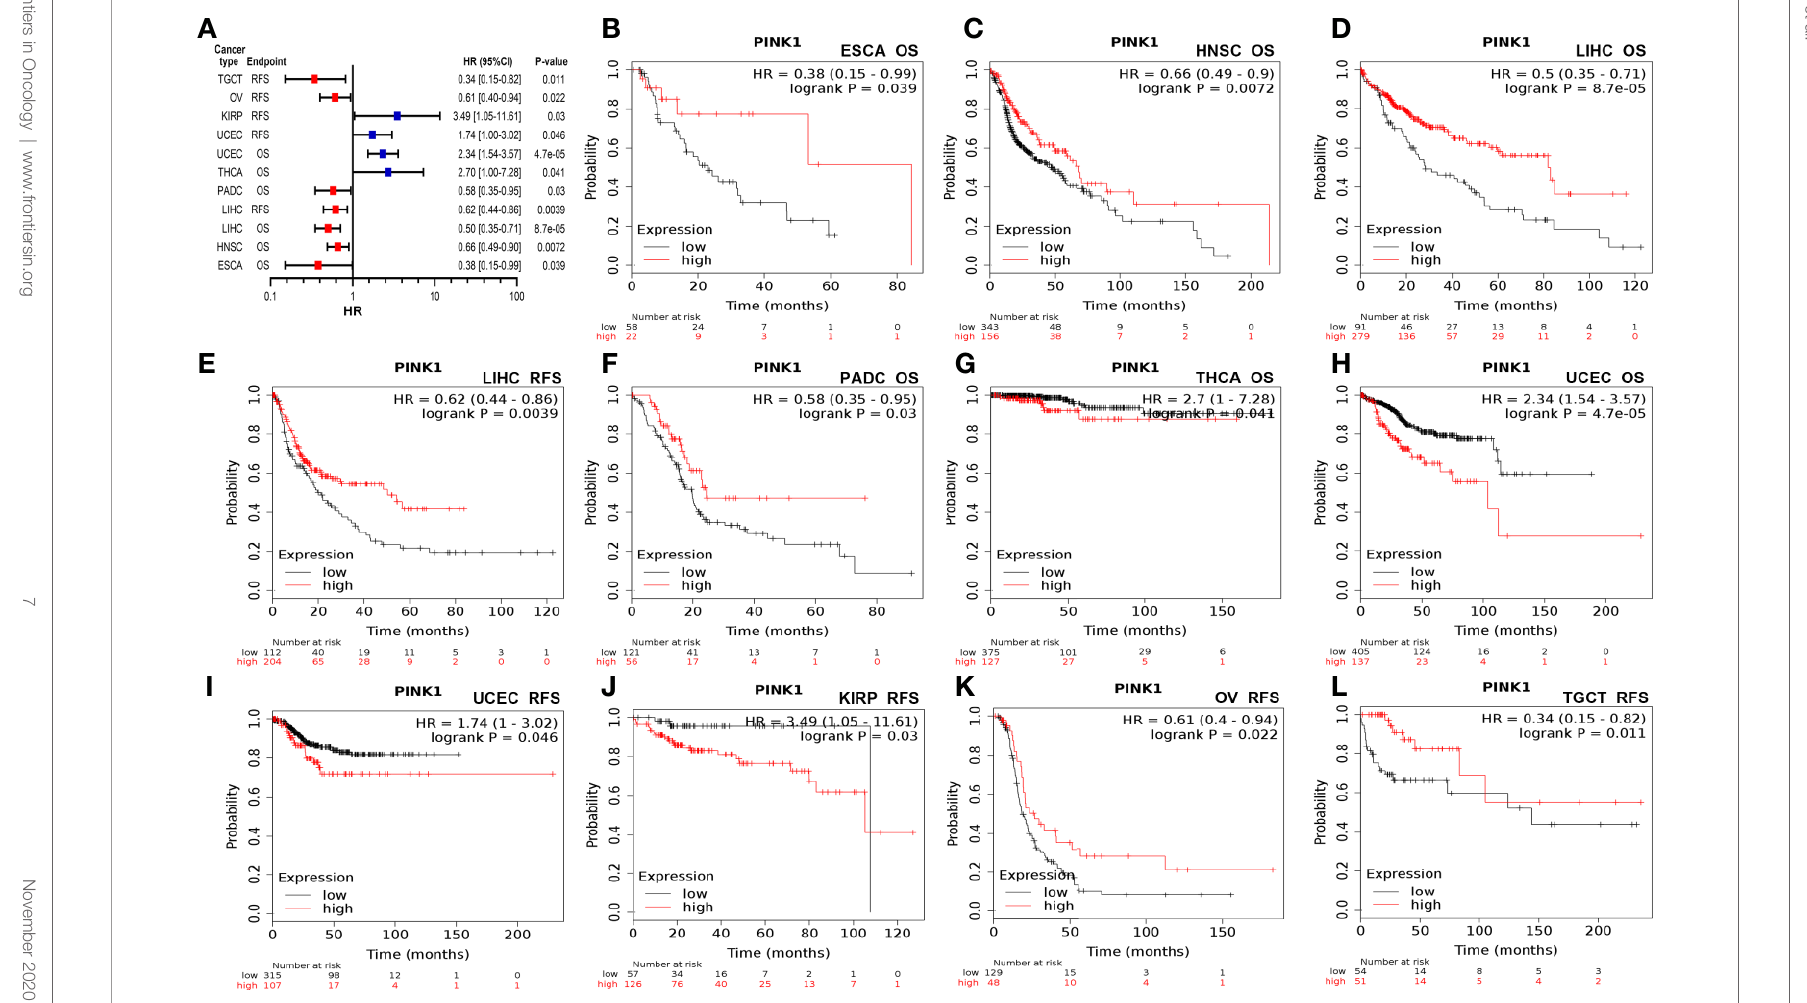
FIGURE 3 | Survival analyses of PINK1 expression in different types of cancer in Kaplan-Meier plotter. (A) Prognostic HR of PIN1K expression in every type pf cancer. (B) OS of ESCA (esophageal adenocarcinoma). (C) OS of HNSC (head-neck squamous cell carcinoma). (D) OS of LIHC (liver hepatocellular carcinoma). (E) RFS of LIHC (liver hepatocellular carcinoma). (F) OS of PADC (pancreatic ductal adenocarcinoma). (G) OS of THCA (thyroid carcinoma). (H) OS of UCEC (uterine corpus endometrial carcinoma). (I) RFS of UCEC (uterine corpus endometrial carcinoma). (J) RFS of KIRP (kidney renal papillary cell carcinoma). (K) RFS of OV (ovarian cancer). (L) RFS of TGCT (testicular germ cell tumor). HR, hazard ratio; CI, con fi dence interval; OS, overall survival; RFS, relapse free